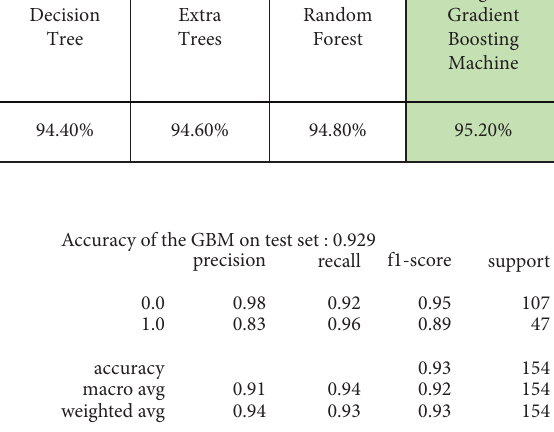
Figure 13: Gradient boosting classifer.